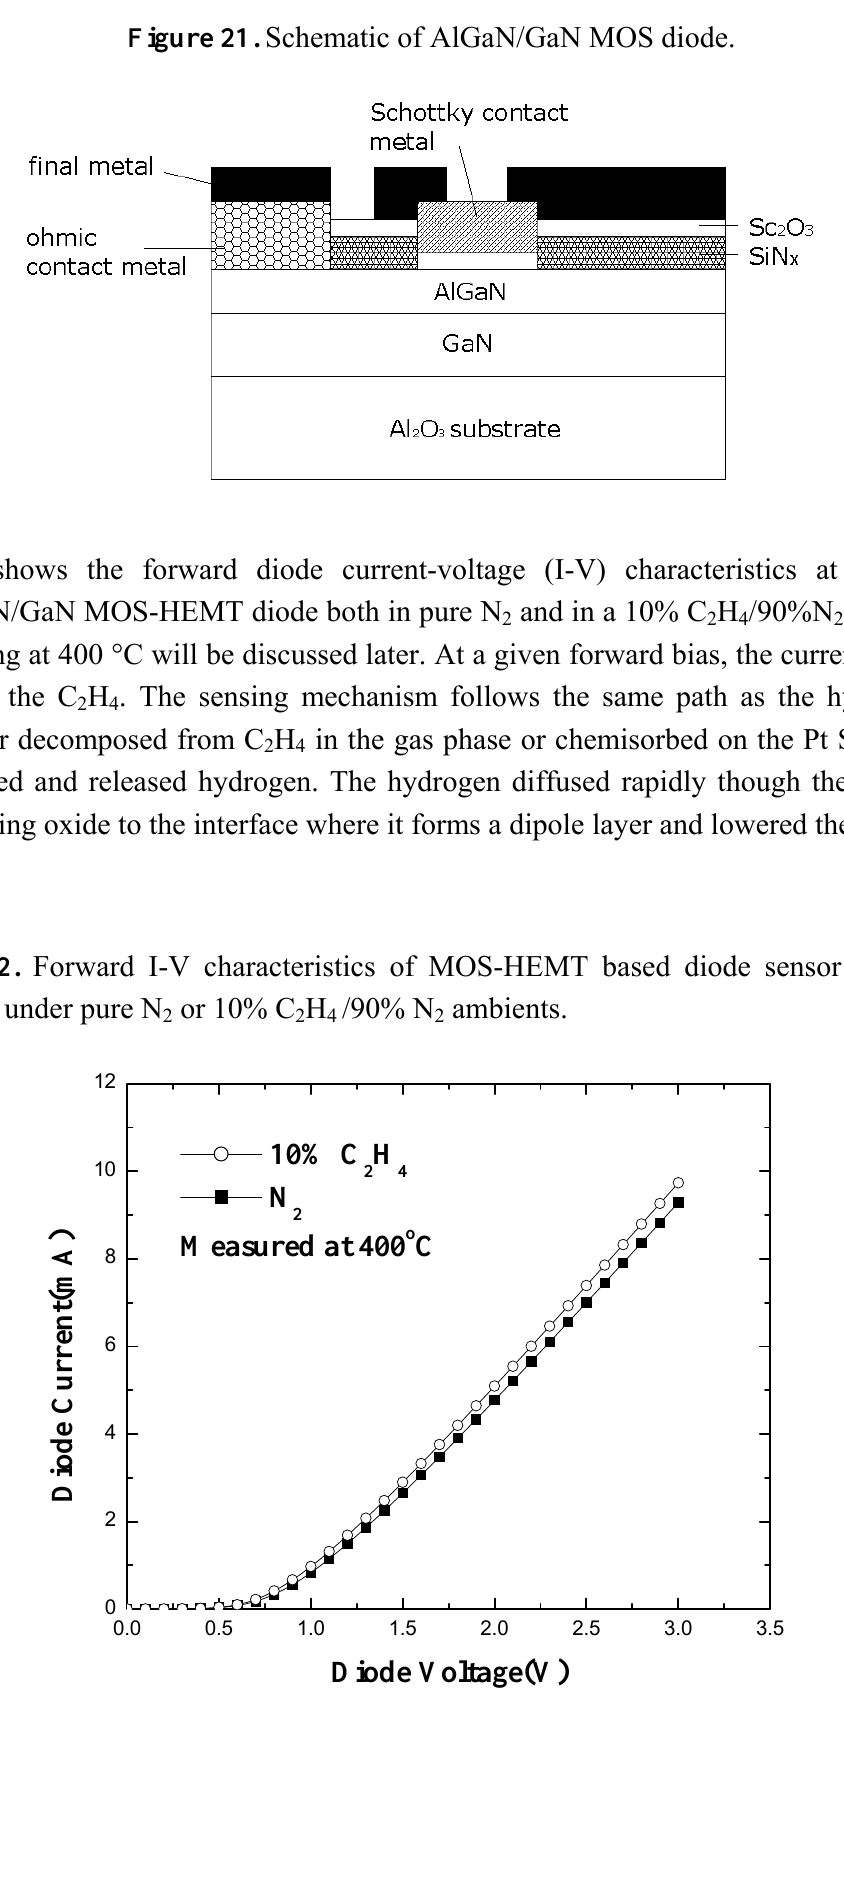
Figure 21. Schematic of AlGaN/GaN MOS diode.